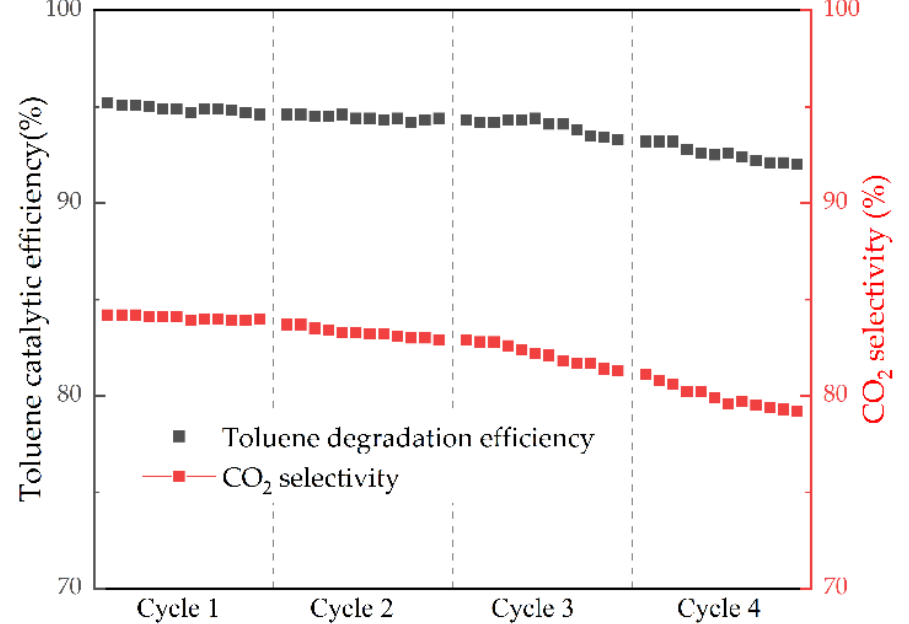
Figure 9. Catalytic stability test for MCD6.